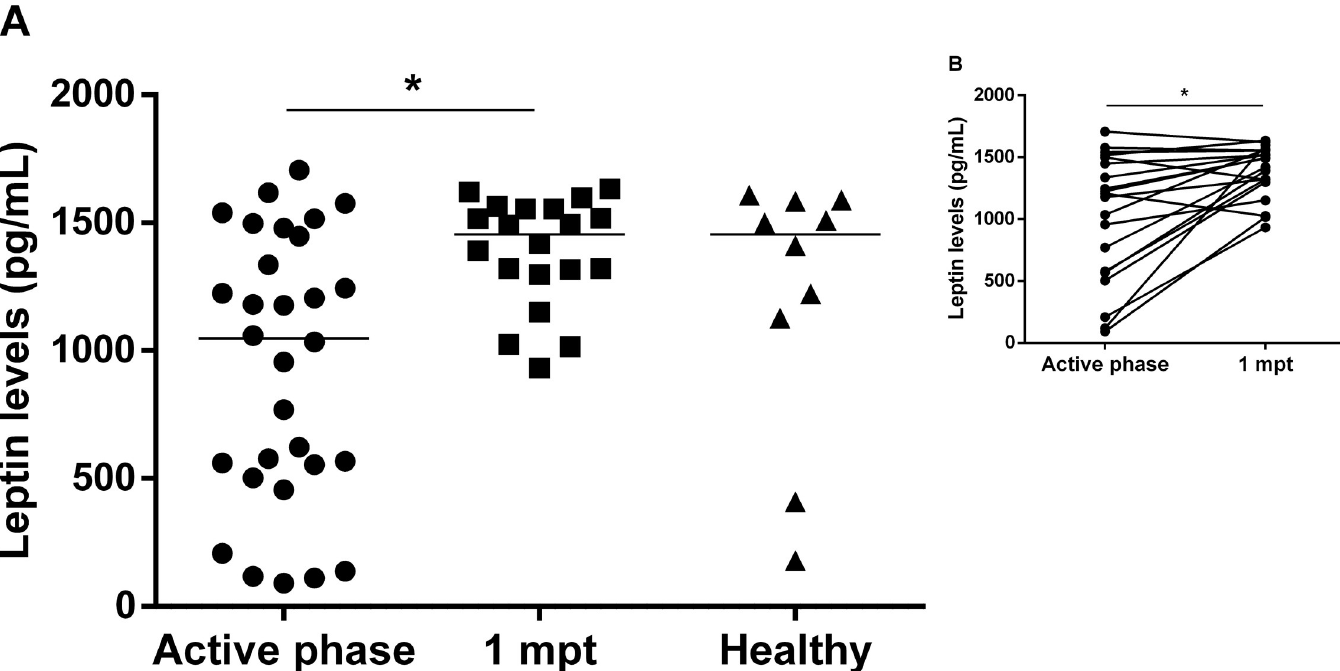
Fig 4. Levels of plasma leptin in patients with visceral leishmaniasis during clinical follow up (VL). (A) Leptin levels of VL patients in the active phase (n = 31), after one-month post-treatment (1 mpt, n = 22) and in healthy volunteers. (B) The insert shows the same patients prospectively evaluated in two different time points (n = 22). Each symbol represents one patient. The horizontal bar represents the median values. Asterisks denote a statistically significant difference between groups, � p < 0.05; �� p < 0.01.